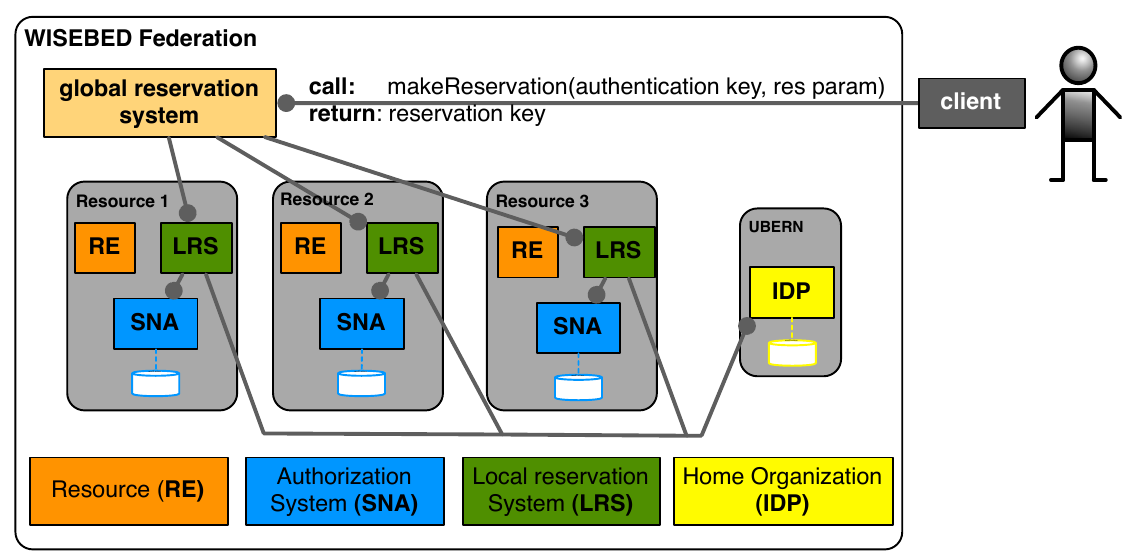
Figure 6. Message Flow: Make